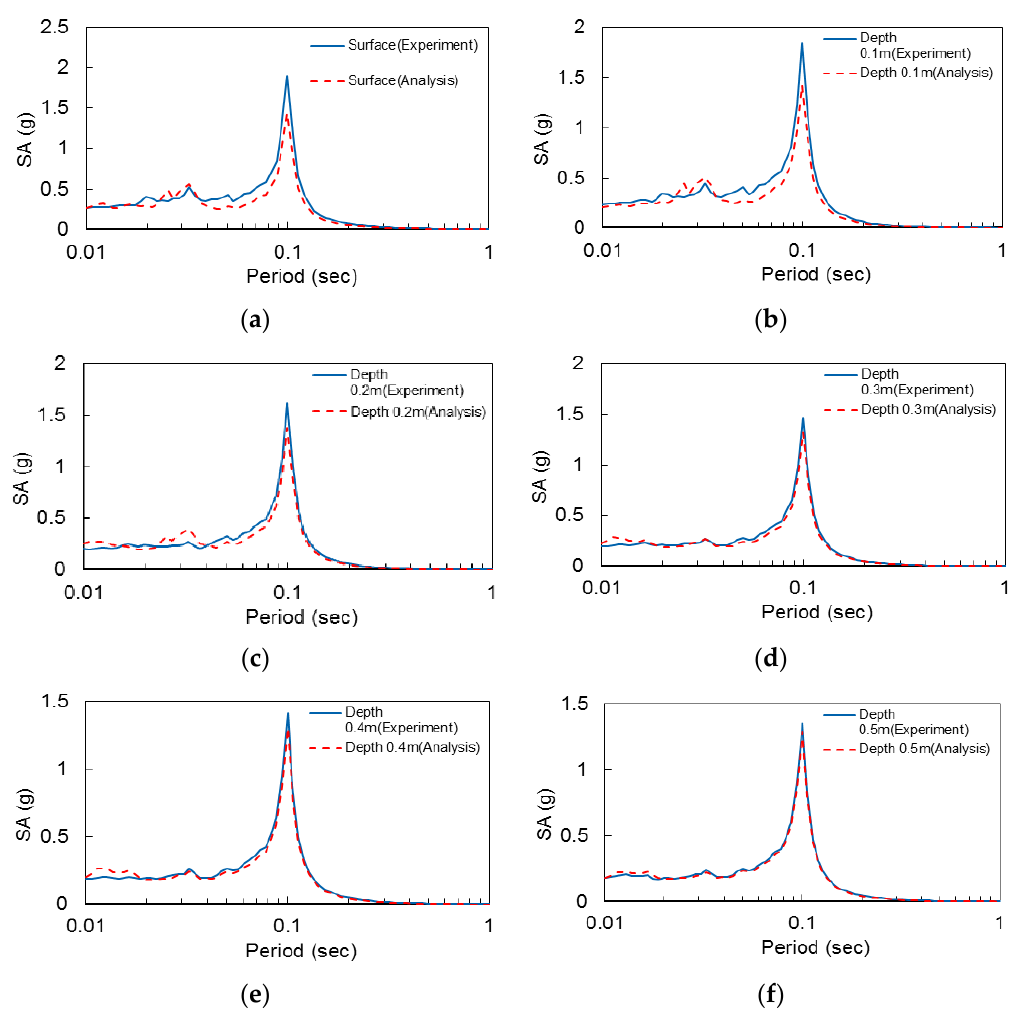
Figure 15. ( a ) SA by sine 10 Hz wave at Surface; ( b ) SA by sine 10 Hz at 0.1 m depth; ( c ) SA by sine 10 Hz at 0.2 m depth; ( d ) SA by sine 10 Hz at 0.3 m depth; ( e ) SA by sine 10 Hz at 0.4 m depth; ( f ) SA by sine 10 Hz at 0.5 m depth.